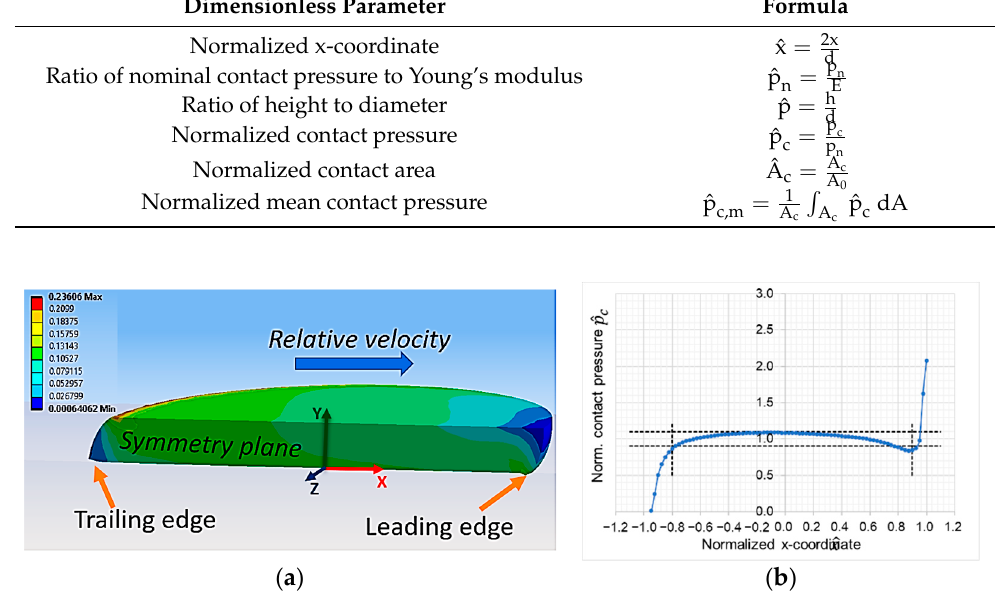
Figure 7. ( a ) Equivalent strain of deformed polymer pin (deformation is scaled by a factor of three); ( b ) the corresponding normalized contact pressure along the symmetry axis for base parameters.